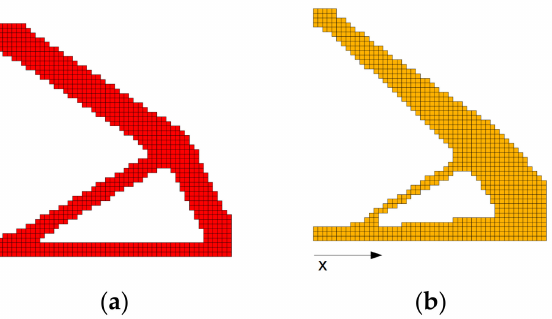
Figure 4. Final topologies obtained for square structure for FGM-RAMP material interpolation scheme, x -direction of material gradation: ( a ) uniform material, minimal compliance: 2.560 Nm; ( b ) graded material according to Equation (7), minimal compliance: 15.173 Nm.